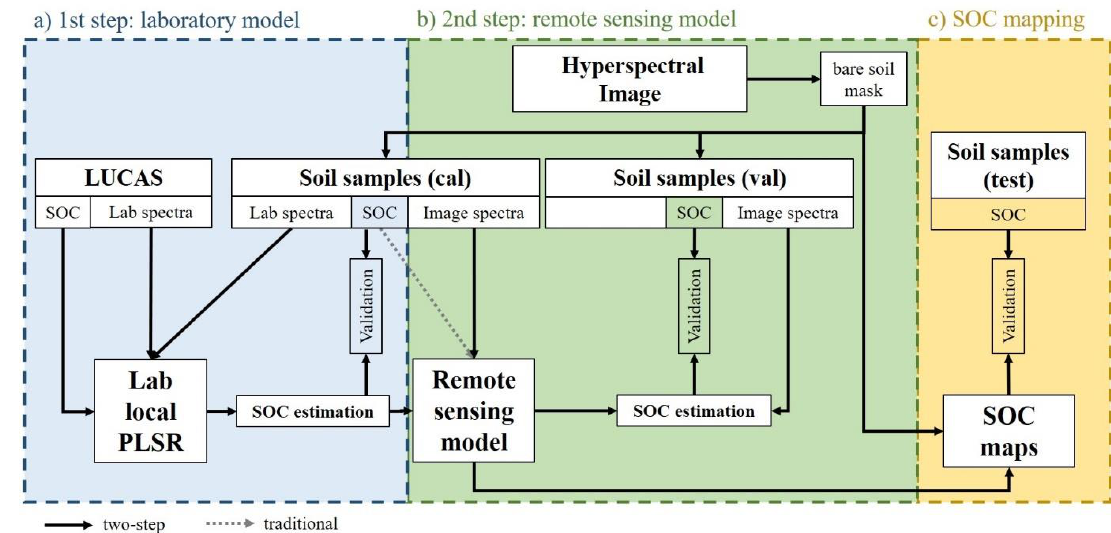
Figure 3. Overview of the processing scheme with ( a ) laboratory model, ( b ) remote sensing model and ( c ) SOC mapping. LUCAS: land use/cover area frame survey; PLSR: partial least squares regression.